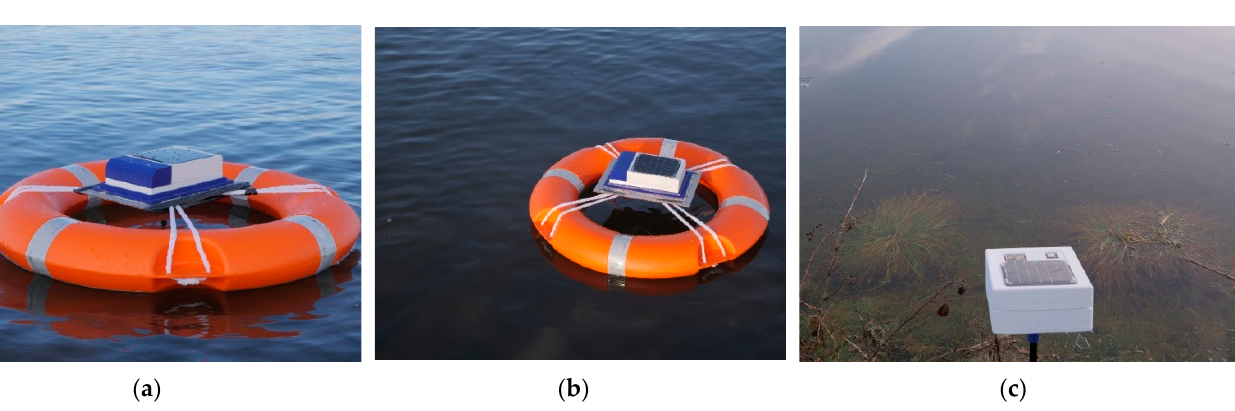
Figure 11. Buoyed sensor node deployed in the North Sea ( a ) with buffer, ( b ) without buffer. ( c ) Data relay node for RSSI tests.